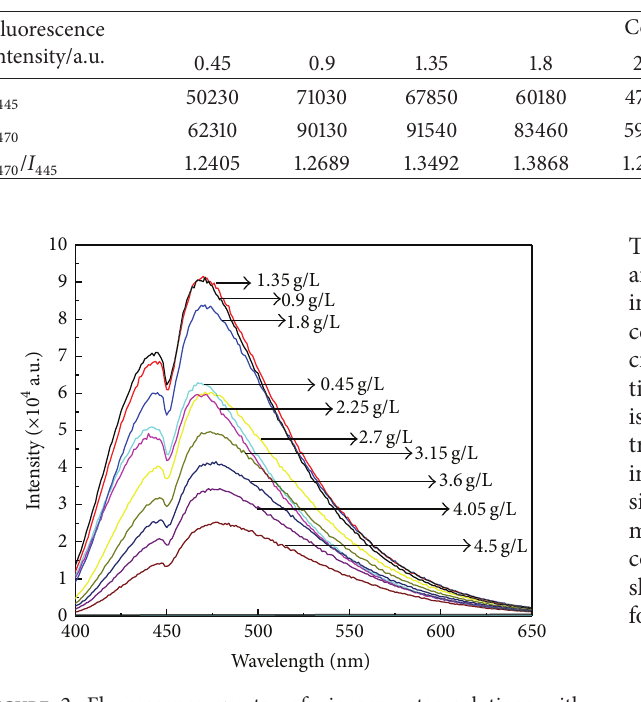
Figure 2: Fluorescence spectra of vinegar-water solutions with different CH 3 COOH